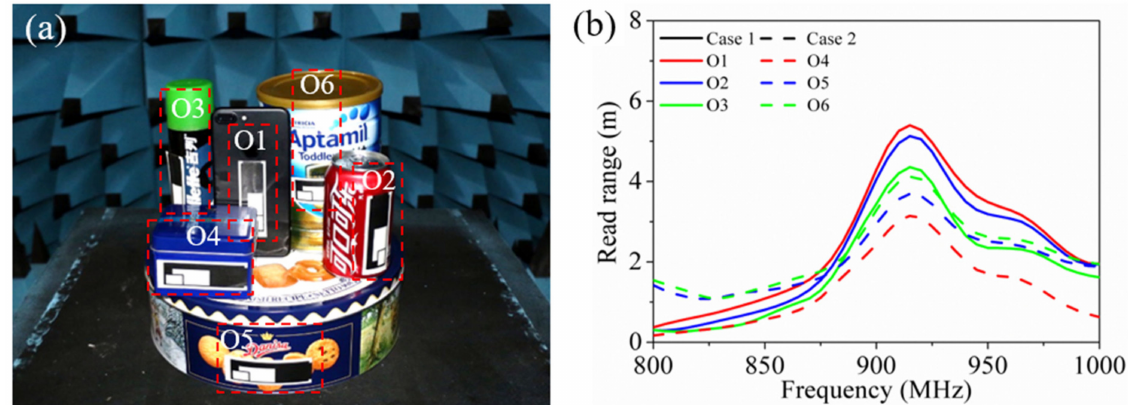
Figure 15. Tag conformal application on daily metallic objects: ( a ) schematic diagram; ( b ) measured read ranges of the tag on the 6